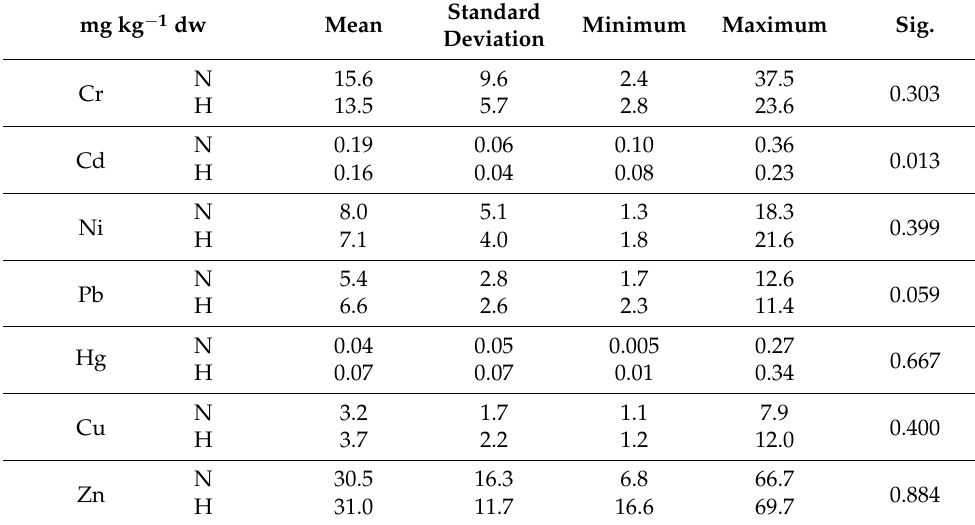
Table 2. Statistical parameters for the measured metals in natural vs. harbour water bodies in VC (N: no harbour presence in these water bodies; H: harbour existence in these water